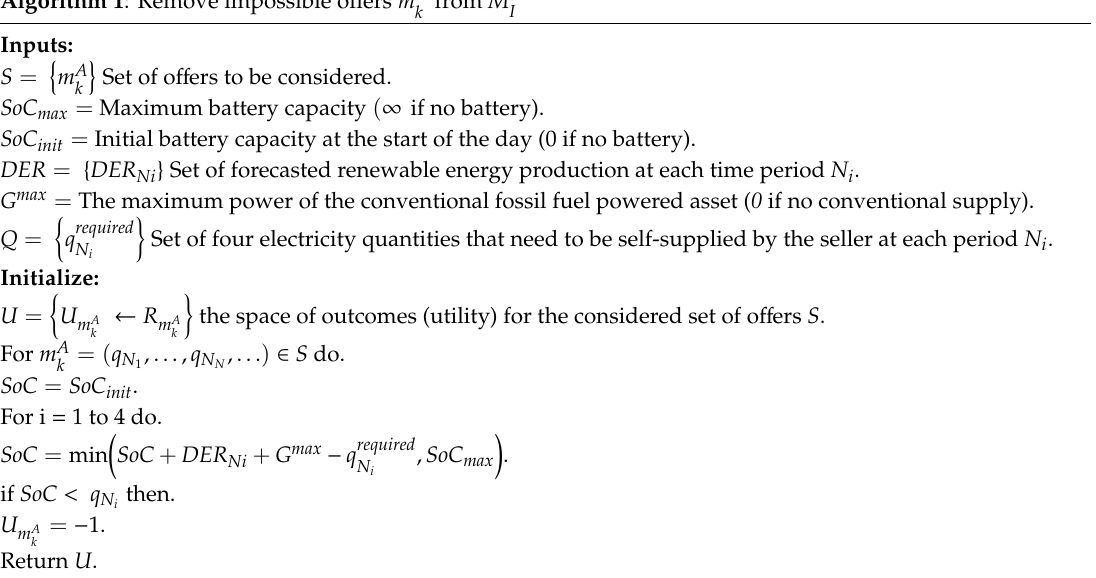
Algorithm 1 : Remove impossible o ff ers m A